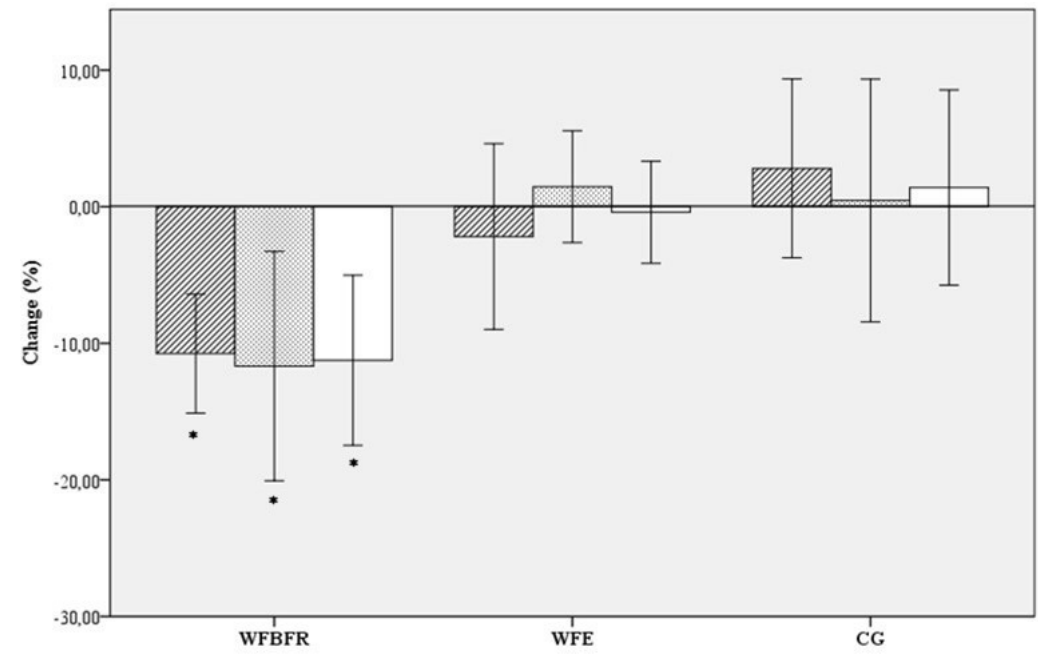
Figure 2. Percentage changes from pre- to post-test for variables: systolic blood pressure (SBP, hatched bars), diastolic blood pressure (DBP, stip- pled bars) and mean arterial pressure (MAP, open bars), for low intensity wrist flexion exercise with blood flow restriction (SBP), low intensity wrist flexion exercise (WFE) and control group (CG). Values are means ± SE. * Statistically significant difference from WFE and CG to WFBFR ( p < 0.05).